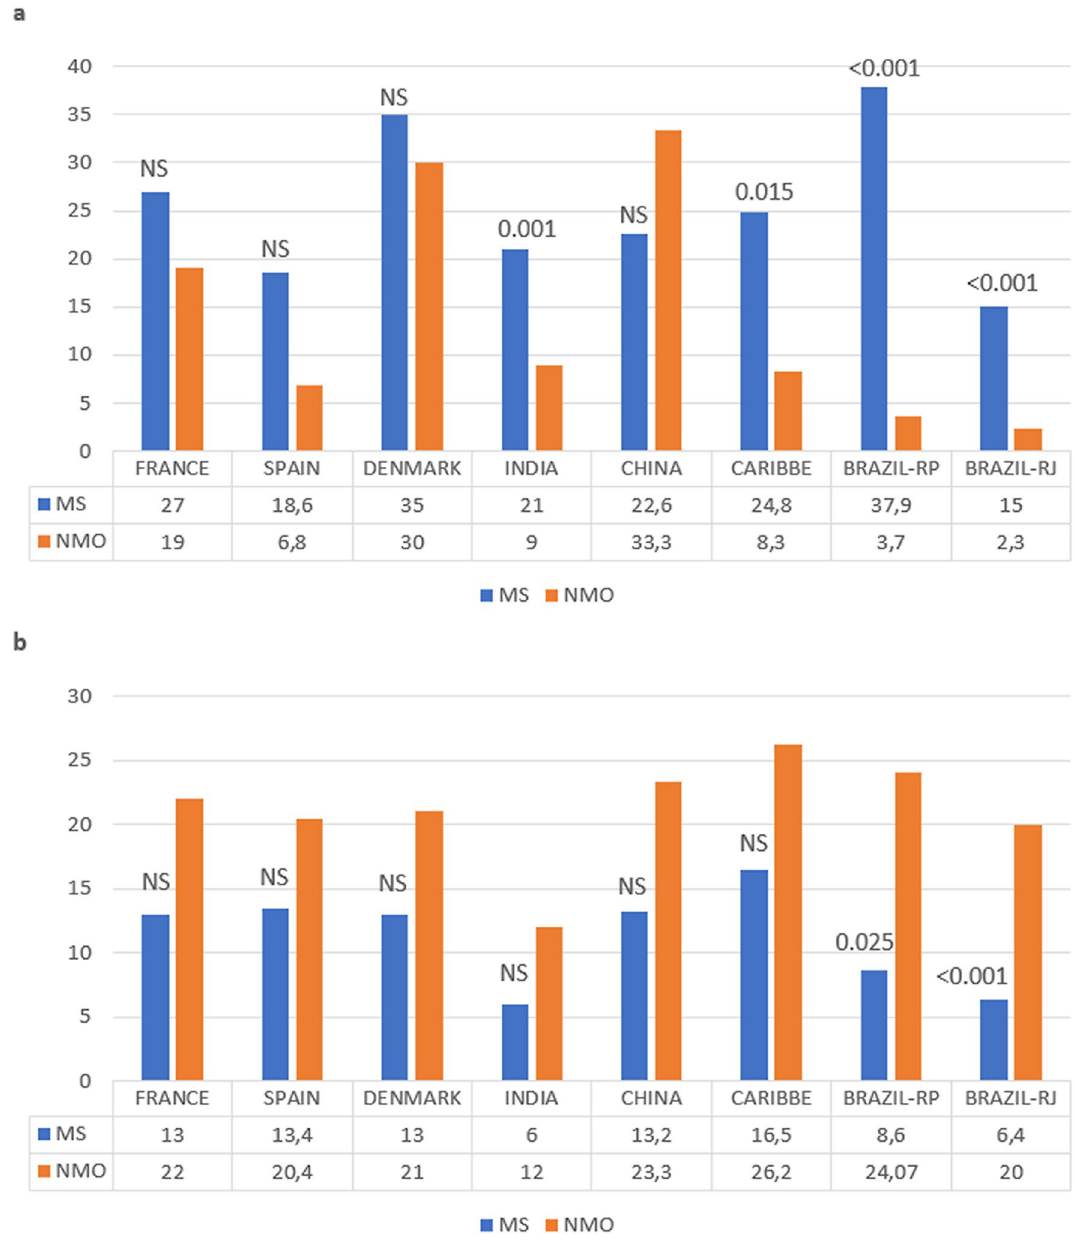
Figure 3. Distribution of the HLA DRB1 alleles associated to NMO and MS in NMO and MS groups. ( a ) Comparison of the frequency of DRB1 *15 allele group in the NMO and MS groups. ( b ) Comparison of the frequency of DRB1 *03 allele group in the NMO and MS groups. Caucasians do not differ in terms of the DRB1 allelic profile. Brazilian populations with strong African ancestry (Ribeirão Preto (RP) and Rio de Janeiro (RJ) had different distribution of DRB1 alleles in NMO and MS groups. The significance ( p ) of each comparison is shown in the figure. NS not